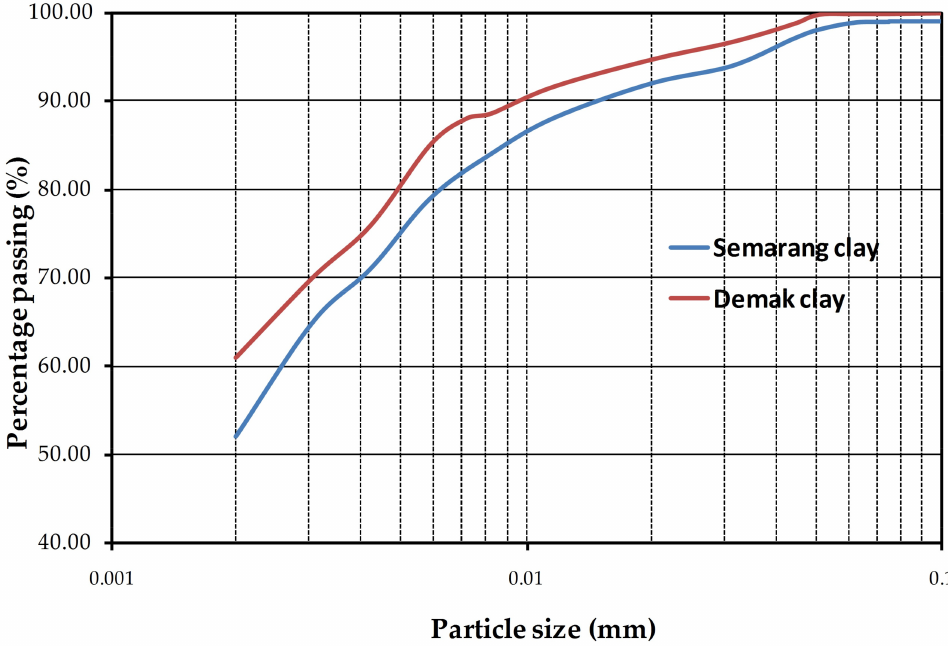
Figure 5. Grain size distribution of Semarang-Demak clay.